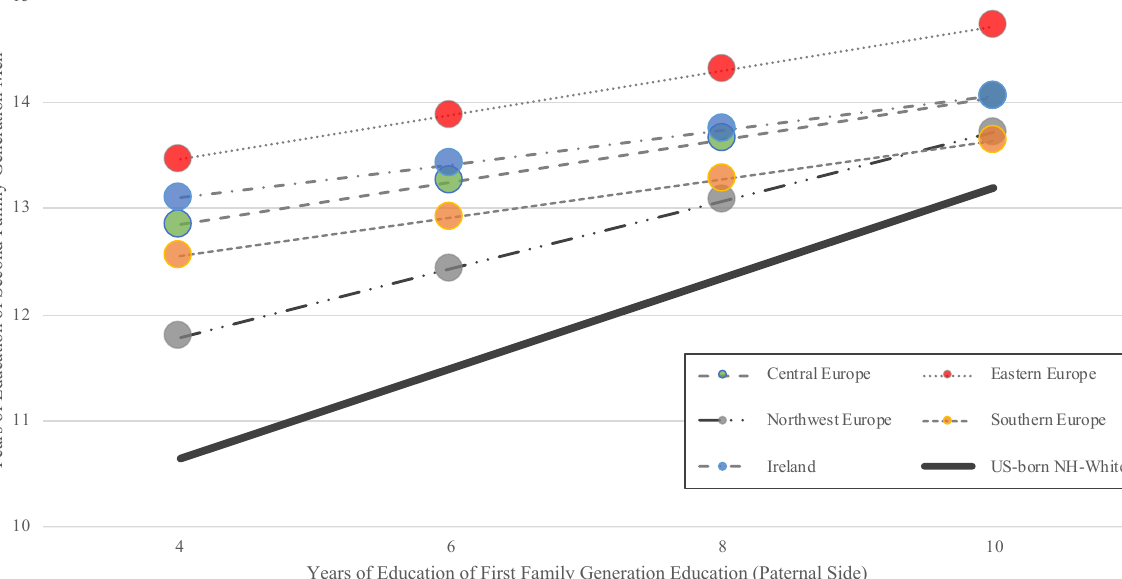
Figure 5: Predicted years of education by paternal education among second family generation men. US-born NH-White indicates U.S.-born non-Hispanic white. Approved for disclosure on November 2, 2020; review number: